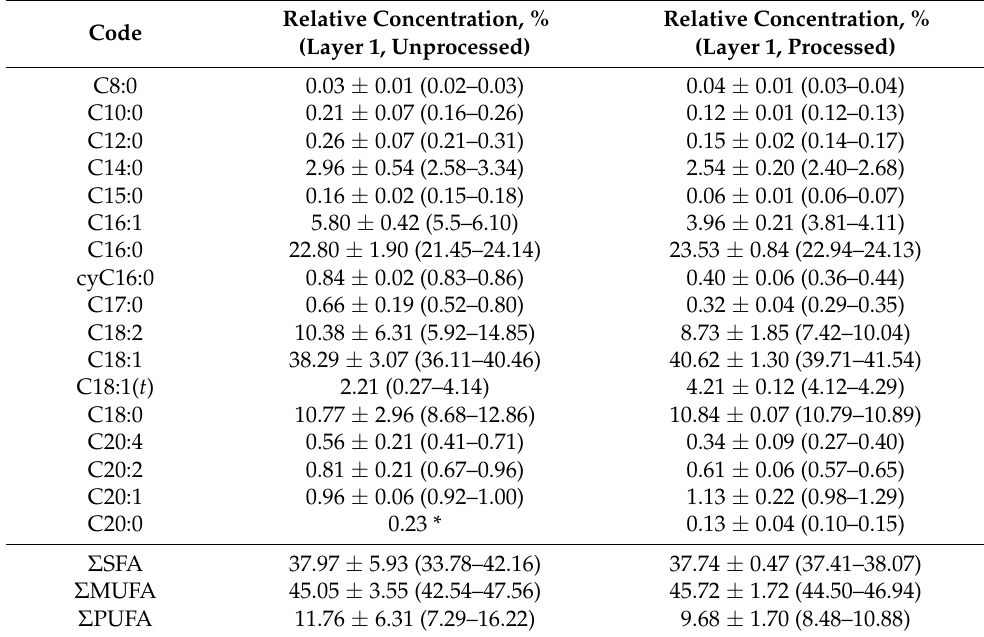
Table 2. Relative concentrations of the main FAMEs identified by GC-MS analysis in the raw (unprocessed) and thermally processed lipid fraction (layer 1, codes U1 and P1) from Mangalitza hard fat. Values are expressed as mean ± SD and data range (in parenthesis).